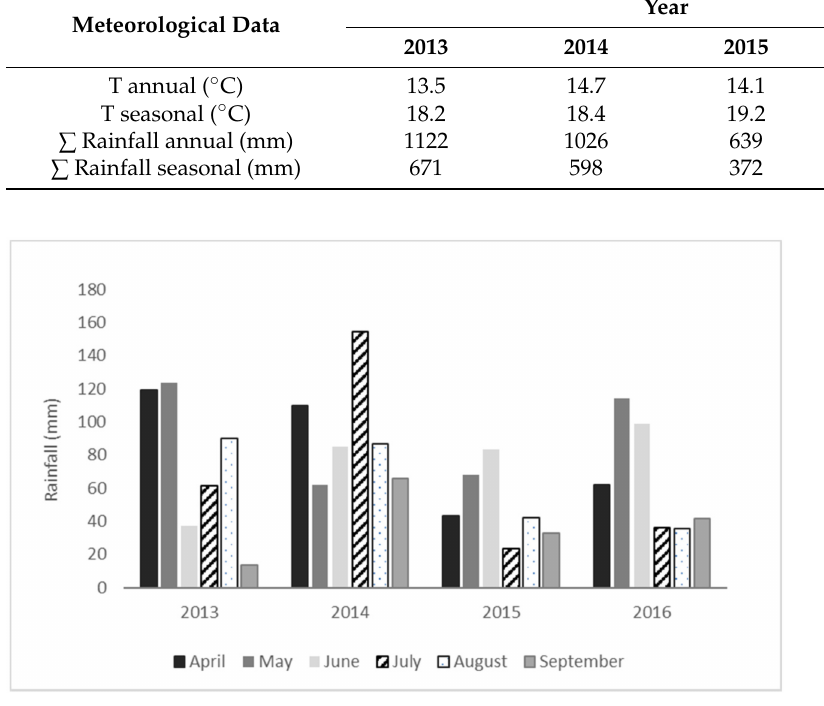
Figure 2. Monthly rainfall during the growing season in the four study-years.